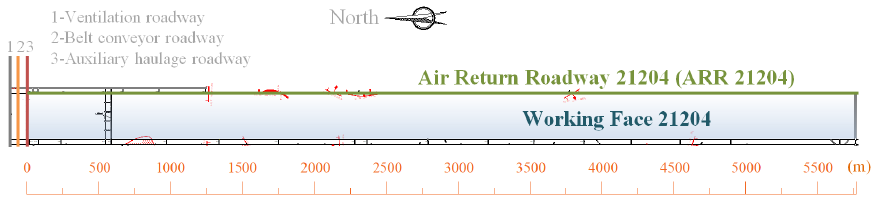
Figure 1. Layout of the working face and roadway location.